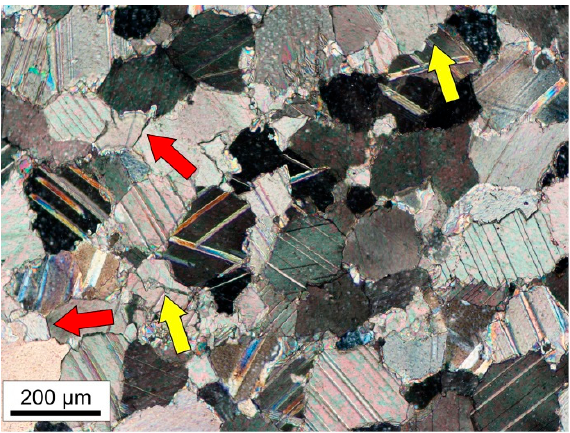
Figure 7. Typical granoblastic structure of the marble of Piastrone quarry: both straight (red arrows) and lobated (yellow arrows) grain boundaries can be recognized in calcite crystals.